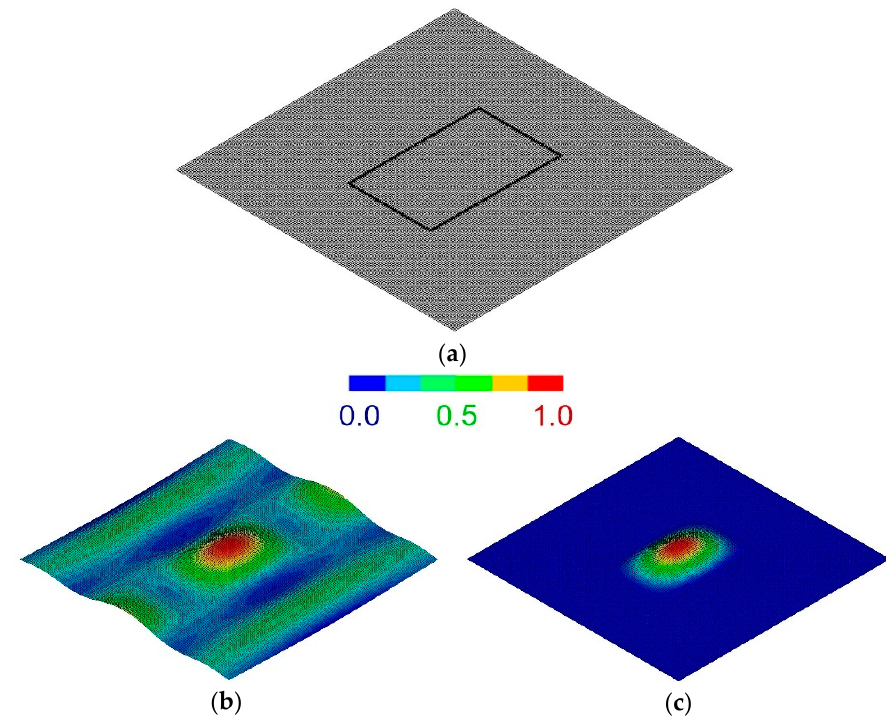
Figure 3. Comparison of local simply supported and clamped boundaries: ( a ) finite element model with highlighted path of constrained nodes; ( b ) modal analysis results with simply supported boundaries; ( c ) modal analysis results with clamped boundaries [55,56].